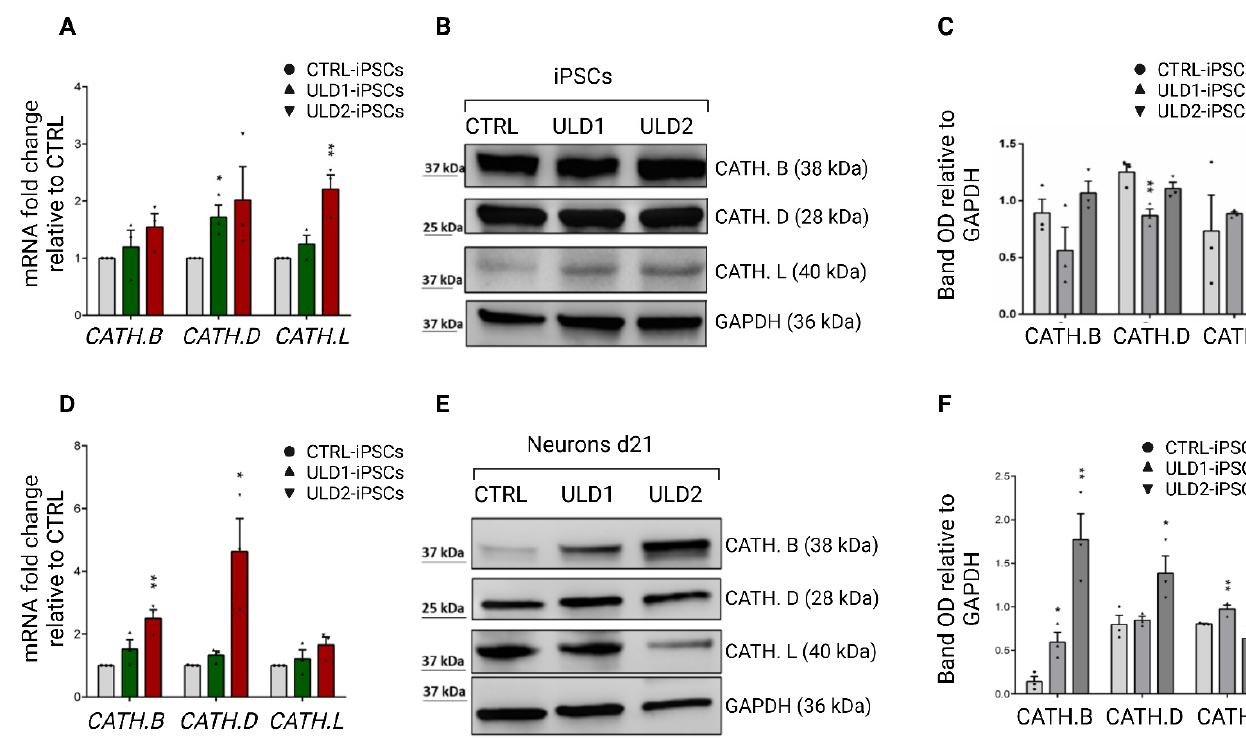
Figure 5. Gene and protein expression analysis of cathepsins B, D and L in iPSCs and neurons derived from CTRL and ULD patients. (Top panel) ( A ) qRT-PCR analysis of cathepsins mRNA expression in iPSCs. ULD patient-derived iPSCs show a higher expression of cathepsins compared to CTRL iPSCs. ( B ) Western blot analysis of total lysates obtained from CTRL and ULD iPSCs does not show an enhanced cathepsins expression in patients iPSCs compared to control. ( C ) Densitometric analysis of WB results, performed using ImageJ software. (Bottom panel) ( D ) qRT-PCR analysis of cathepsins mRNA expression in neurons at day 21 of differentiation. ULD patient-derived neurons show a higher expression of cathepsins genes compared to control. ( E ) Western blot analysis of total lysates obtained from CTRL and ULD neurons results in an overall increase of cathepsins protein expression (particularly cathepsins B and D for ULD2) in patients compared to control, ( F ) Densitometric analysis of WB results, performed using ImageJ software. In all WB analyses, GAPDH was used as loading control. qRT-PCR and WB data are each presented as mean ± SEM of three independent experiments (black dots), * p ≤ 0.05, ** p ≤ 0.01. For neurons, t -test has been calculated vs. CTRL at the same day of differentiation.